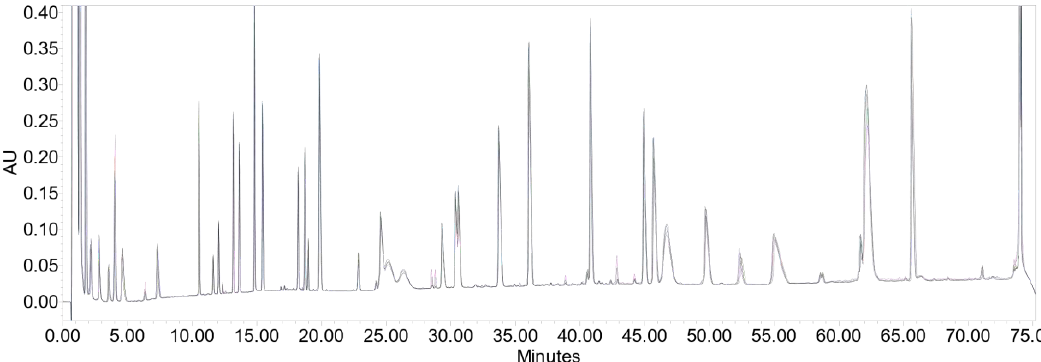
Figure 4. HPLC-UV peptide map of the therapeutic protein. Fragments were prepared by protein digestion, as described in the Materials and Methods Section.